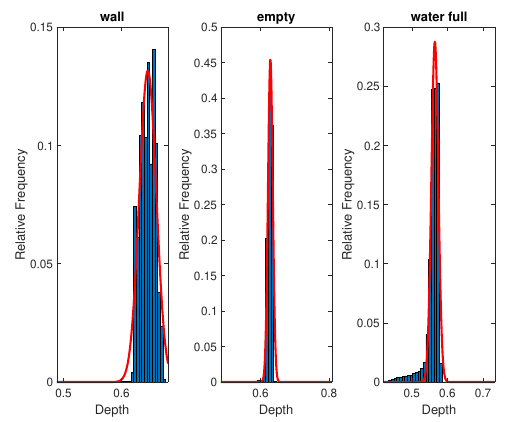
Figure 3. Normal distribution fitting of the depth estimates for D415 acquisitions.